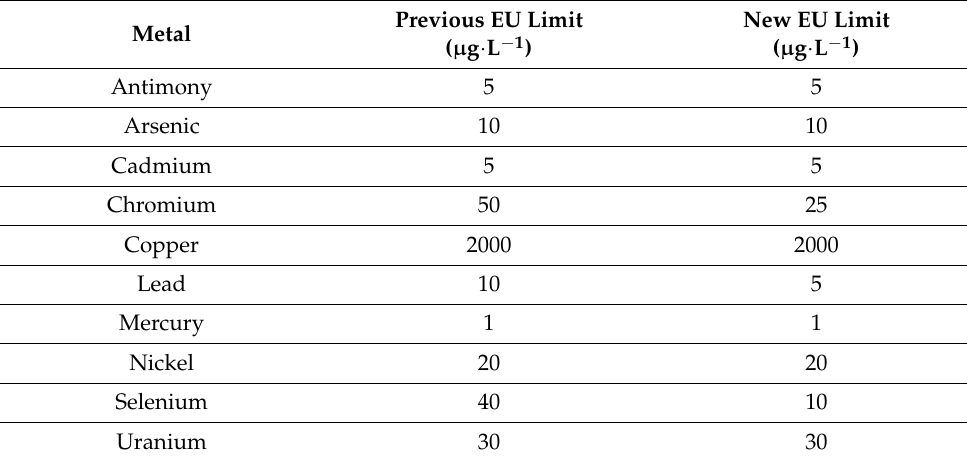
Table 1. EU drinking water guidelines as of 2020